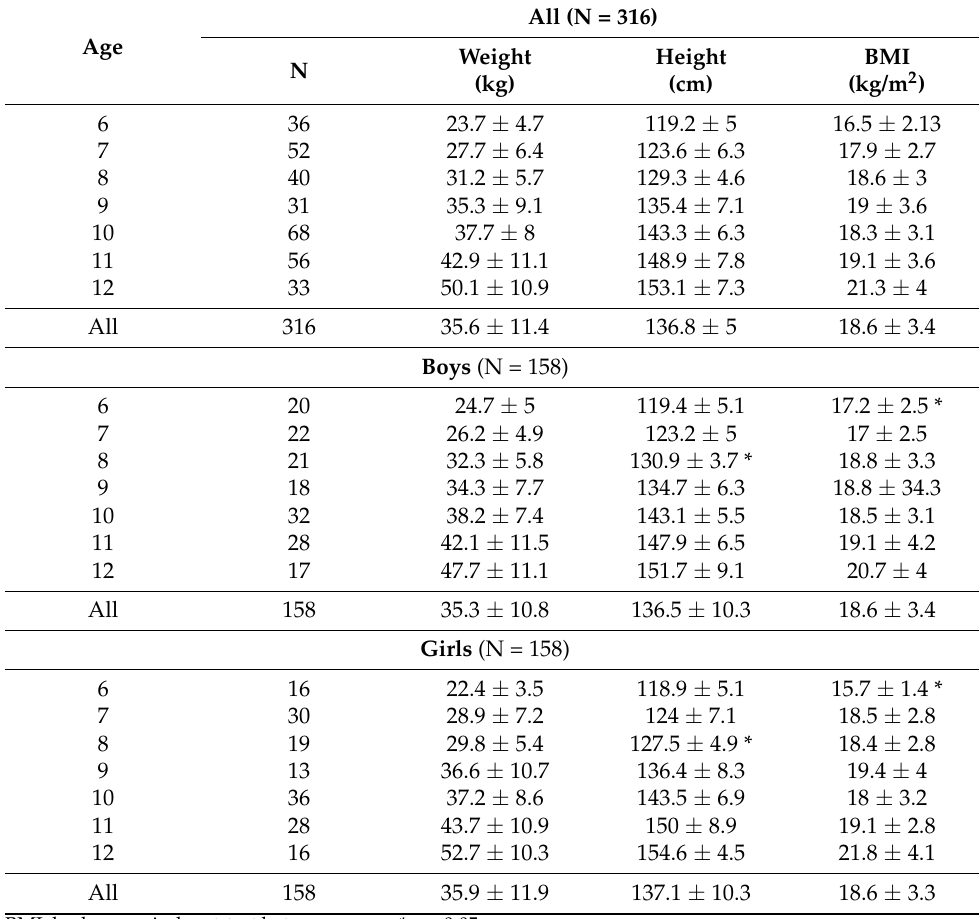
Table 1. Descriptive analysis of the sample (mean ± standard deviation).